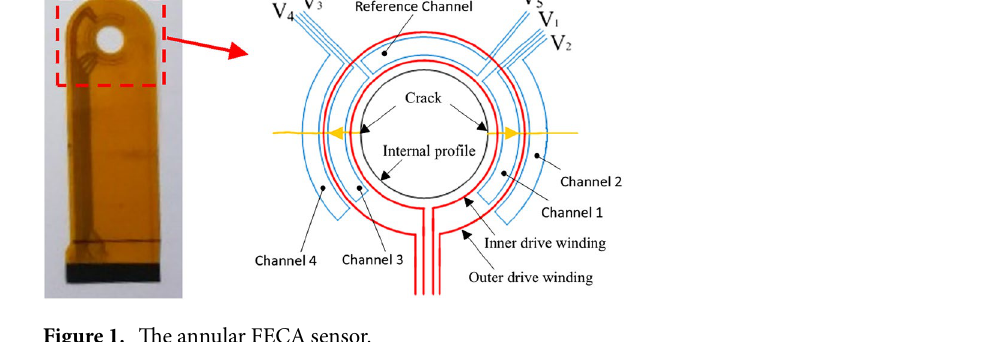
Figure 1. The annular FECA